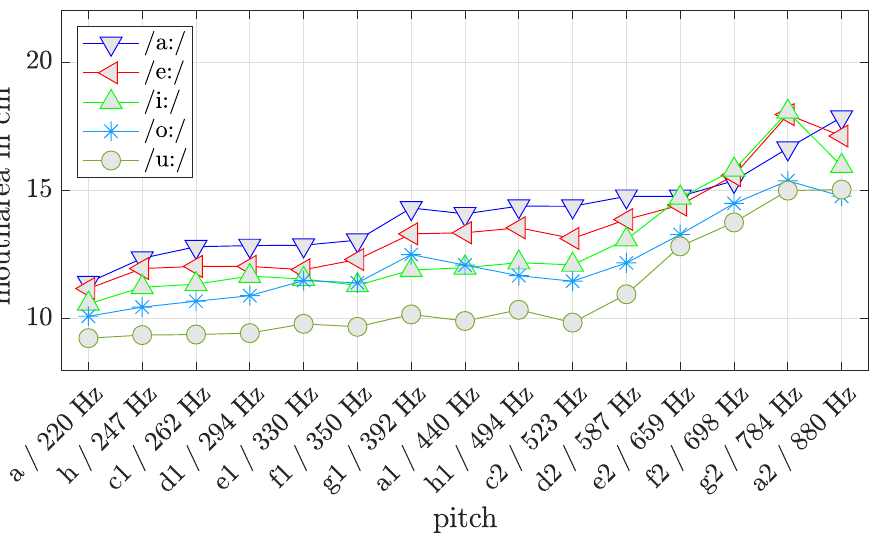
Figure 4. Directivity patterns for female and male singers in the horizontal and vertical plane at low (a/A3/220 Hz) and high (a1/A4/440 Hz) pitch for all five vowels of high-passed signals (1 kHz). The multiple lines of the same color represent the results for each singer for a specific vowel. The vowel data is averaged over all phonation modes. ( A ) Female singers (horizontal, a/A3/220 Hz), ( B ) Male singers (horizontal, a/A3/220 Hz), ( C ) Female singers (vertical, a/A3/220 Hz), ( D ) Male singers (vertical, a/A3/220 Hz), ( E ) Female singers (horizontal, a1/A4/440 Hz), ( F ) Male singers (horizontal, a1/A4/440 Hz), ( G ) Female singers (vertical, a1/A4/440 Hz), ( H ) Male singers (vertical, pitch a1/A4/440 Hz).